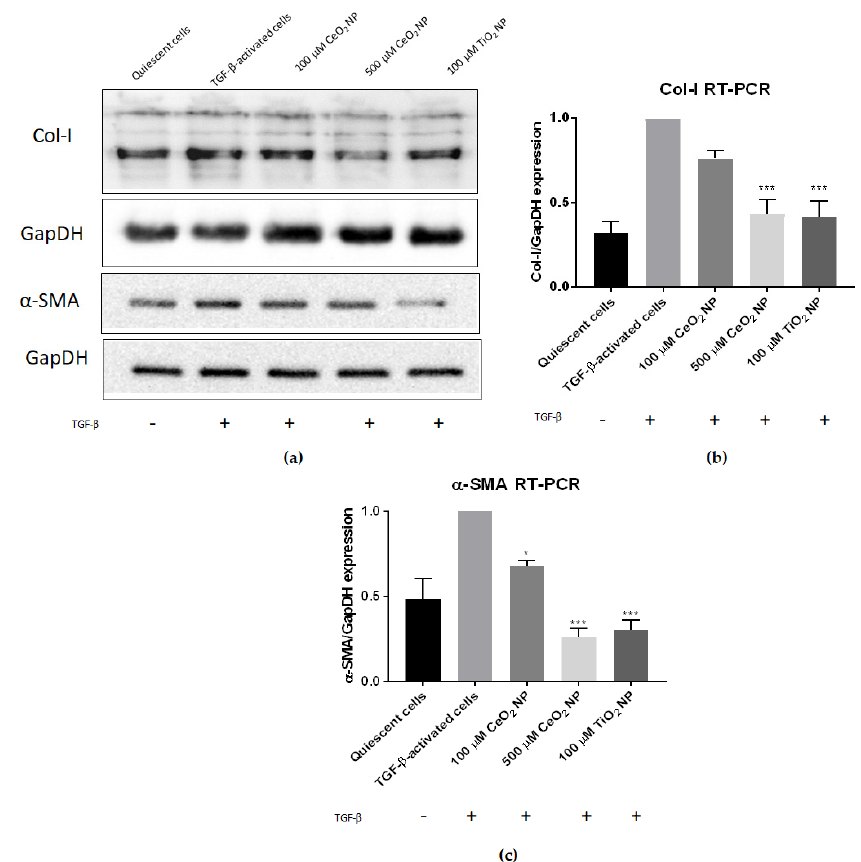
Figure 2. CeO 2 NP reduce fibrogenesis in TGF- β -activated cells. ( a ) Immunoblot analysis showed a dose-dependent reduction in both Col-I and α -SMA protein expression ( n = 4). ( b ) RT-PCR analysis found Col-I expression in 500 µ M CeO 2 NP and TiO 2 NP-treated cells to be significantly reduced ( n = 3). ( c ) RT-PCR analysis found α -SMA expression in 100 µ M CeO 2 NP, 500 µM CeO 2 NP and TiO 2 NP-treated cells to be significantly reduced ( n = 3). Error bars represent SEM; ANOVA was used to calculate significance. * p < 0.05, *** p < 0.001.